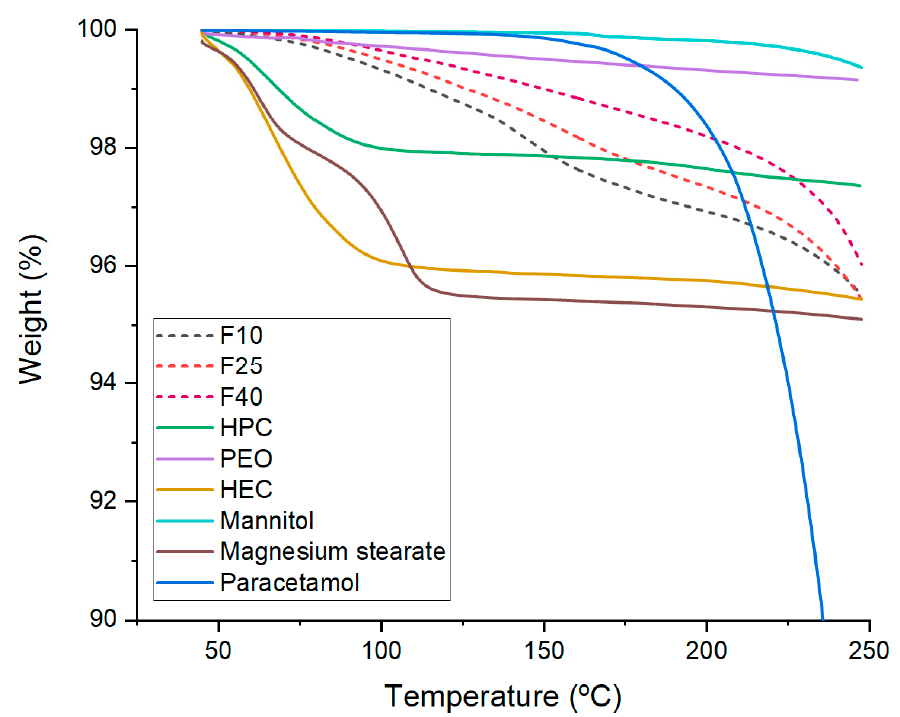
Figure 4. TGA of the filaments, drug, and individual excipients included in the compositions. XRPD and DSC analyses were performed to evaluate in which form the drug was incorporated F10, F25, and F40 were then evaluated in terms of printability. Cylindrical cores (9 mm diameter in the filaments and cores (Figures 5 and 6). XRPD data showed broad halos for F40 and F25 discs x 4 mm height) were printed with all three filaments (cores named C10, C25, and C40, respectively). indicating that the drug was incorporated in an amorphous form. F10, containing a higher amount of HPC (62% w / w ), showed a di ff raction pattern similar to HPC powder, with some small peaks at 18 ◦ and 23 , indicating the presence of either mannitol and / or PEO in a crystalline form. The presence of ◦ crystalline material only in the F10 disc can be explained with the lower extrusion temperature (110 C ◦ compared with 120 C for the other two filaments) or by the plasticizing e ff ect of the increasing drug loading that might have contributed to better solubilization of mannitol and / or PEO in F25 and F40. ◦ DSC analysis (Figure 6) showed small endothermic peaks at 70 C for all the printed formulations, indicating that part of PEO was still in a crystalline form after extrusion and printing. In all the powder ◦ mixtures, a broader peak (composed of two peaks) was present at 160–165 C, indicating that both paracetamol and mannitol were crystalline. However, only a small endothermic peak was present at ◦ 170 C in all the filaments indicating that the drug became amorphous after extrusion. Only in F40 was ◦ a second endotherm still present (shifted at 150 C), indicating that a small amount of the drug was still in crystalline form but could not be detected by XRPD (F40 disc showed a complete amorphous di ff raction pattern, Figure